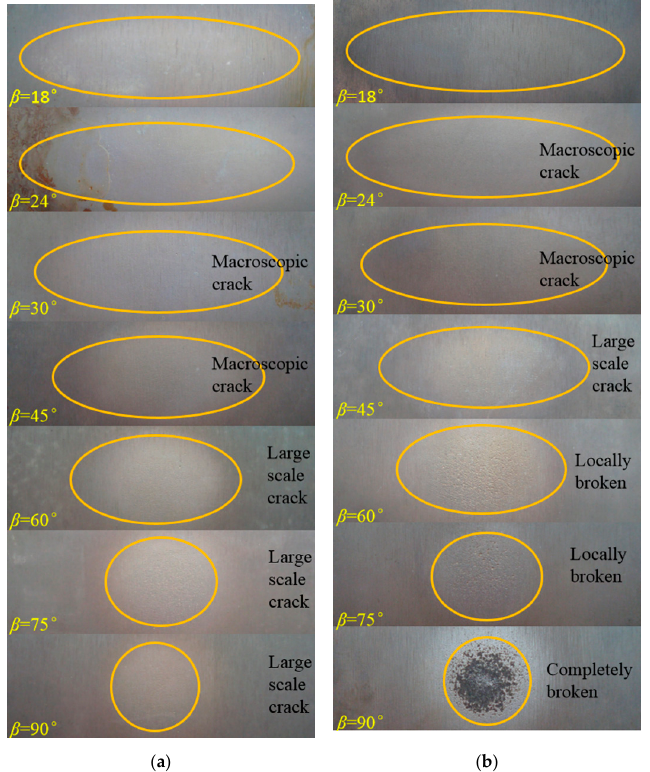
Figure 16. Macroscopic erosion morphology of the boronized coating at 210 m/s and 566 (D ℃ 32 = 226 μ m): ( a ) 210 m/s; ( b ) 320 m/s. (D32 = 226 µ m): ( a ) 210 m/s; ( b ) 320